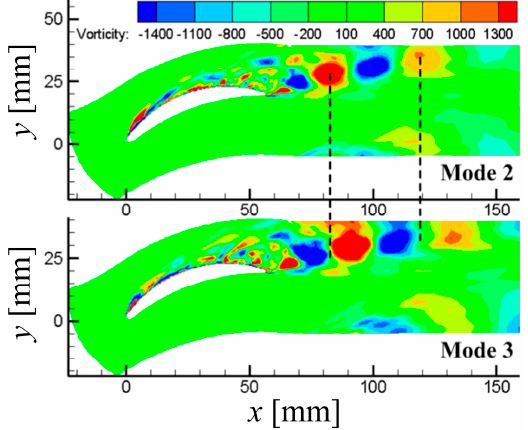
Figure 10. Second and third modes of flow field by POD method.